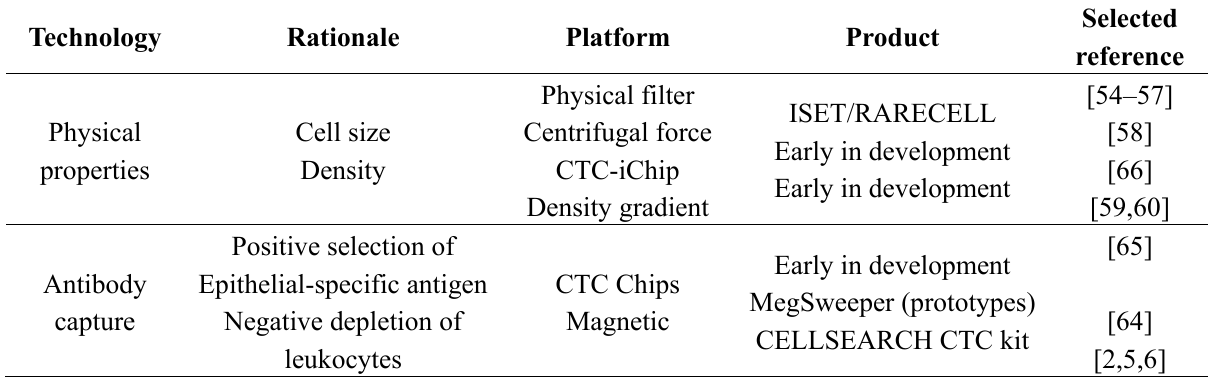
Table 1. CTC enrichment